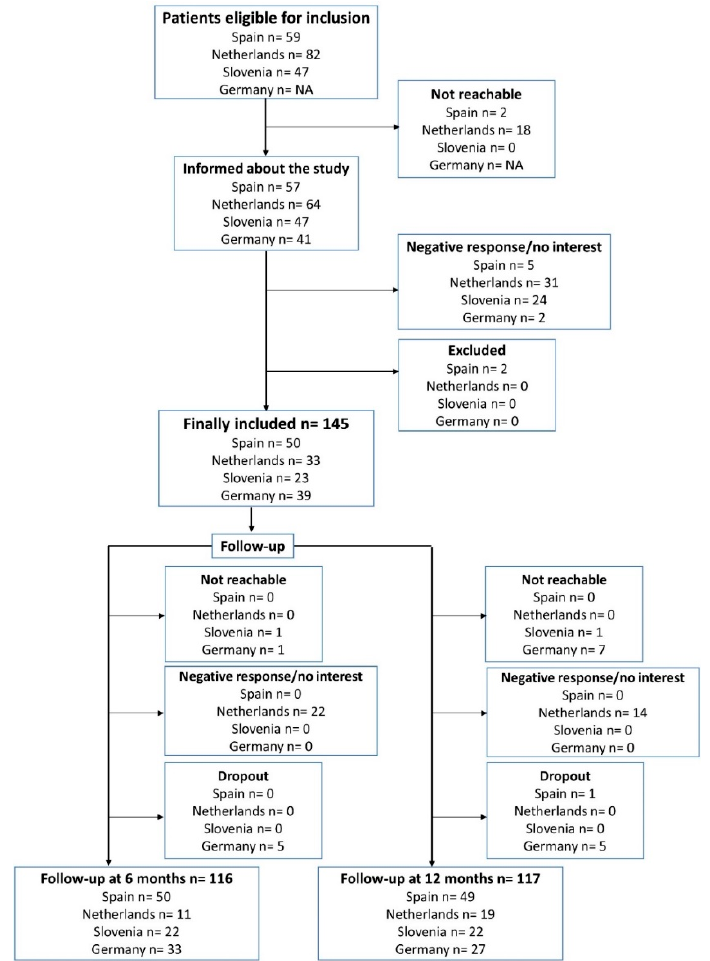
Figure 2. The screening and follow-up phases for the Systems Pharmacology Approach to Uncontrolled Pediatric Asthma (SysPharmPediA) study. Screening details were available from three (Spain, the Netherlands, and Slovenia) out of the four recruiting study centers. NA: not available.